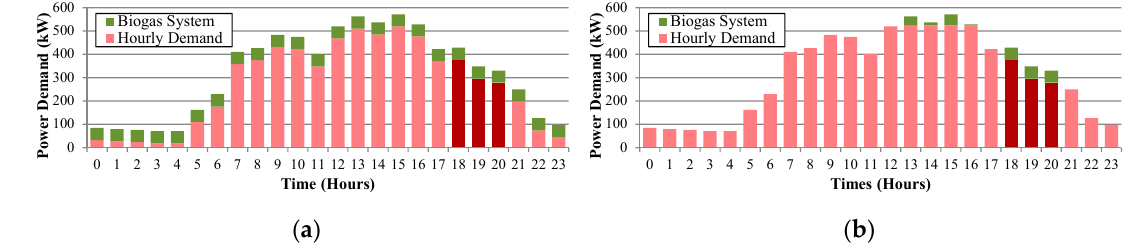
Figure 8. Scenario 6: ( a ) biogas permanent use for strategic conservation and ( b ) Demand graph with limit for alternative generation and peak-shaving application.